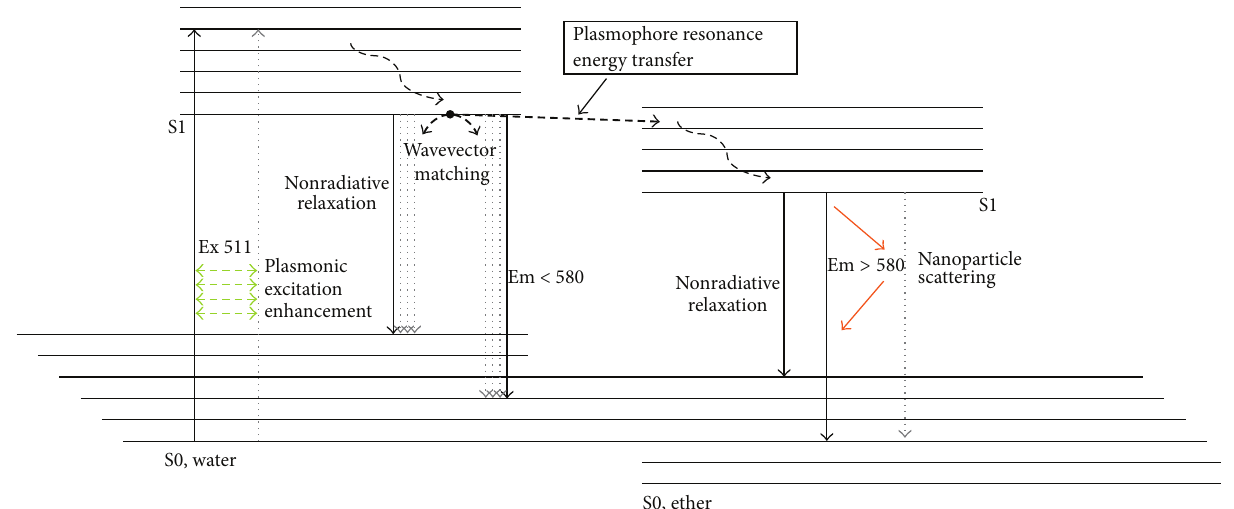
Figure 2: A proposed modified Jablonski diagram for the system. Dotted arrows indicate nanoparticle